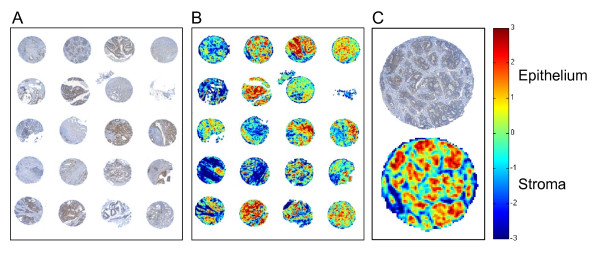
A part of a digitized colorectal cancer tissue microarray (TMA) immunostained with epidermal growth factor receptor (EGFR) antibody (A) and the same TMA as processed by the local binary pattern (LBP/C) classifier (B). One representative tissue spot and its corresponding LBP/C result image. The bar on the right shows the heat map for the LBP/C classifier score values